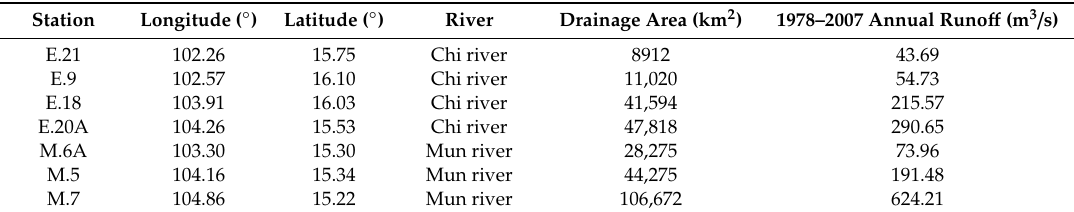
Table 1. The hydrological stations in the mainstream of Mun-chi river Basin.